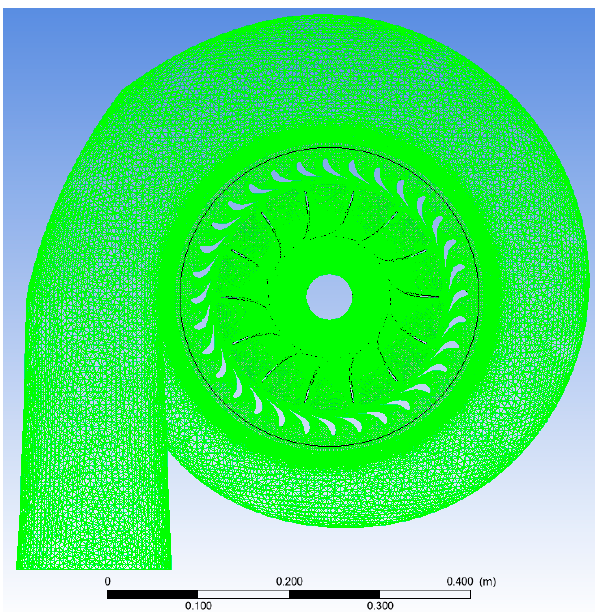
Figure 4. Turbine overall grid diagram.